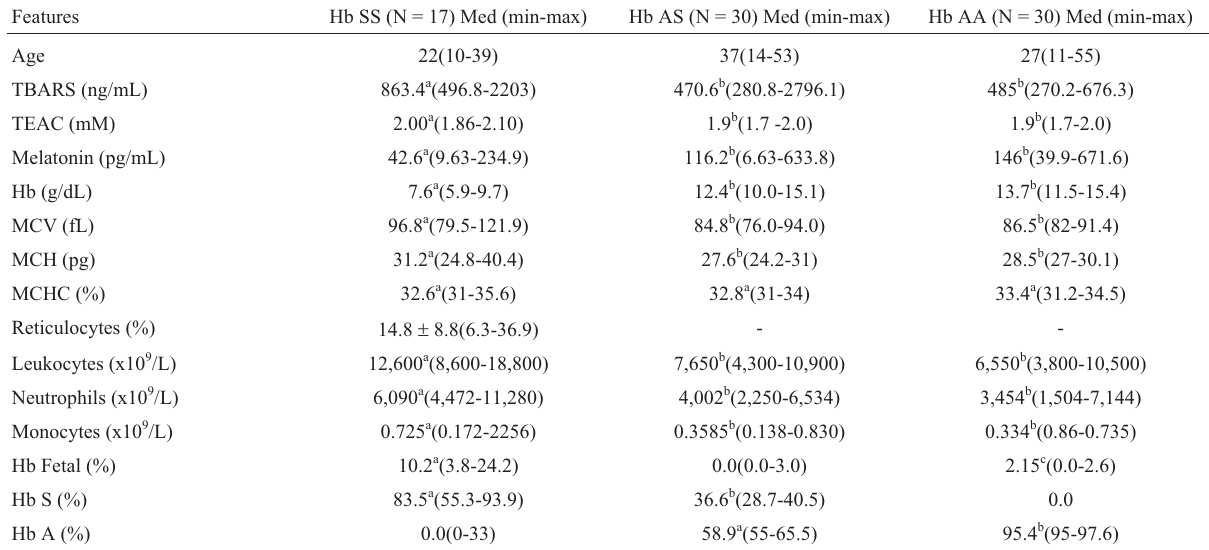
Table 3 - Demographic and laboratory features of individuals with sickle cell anemia (Hb SS), sickle cell trait (Hb AS) and without hemoglobinopathy (Hb AA). Features